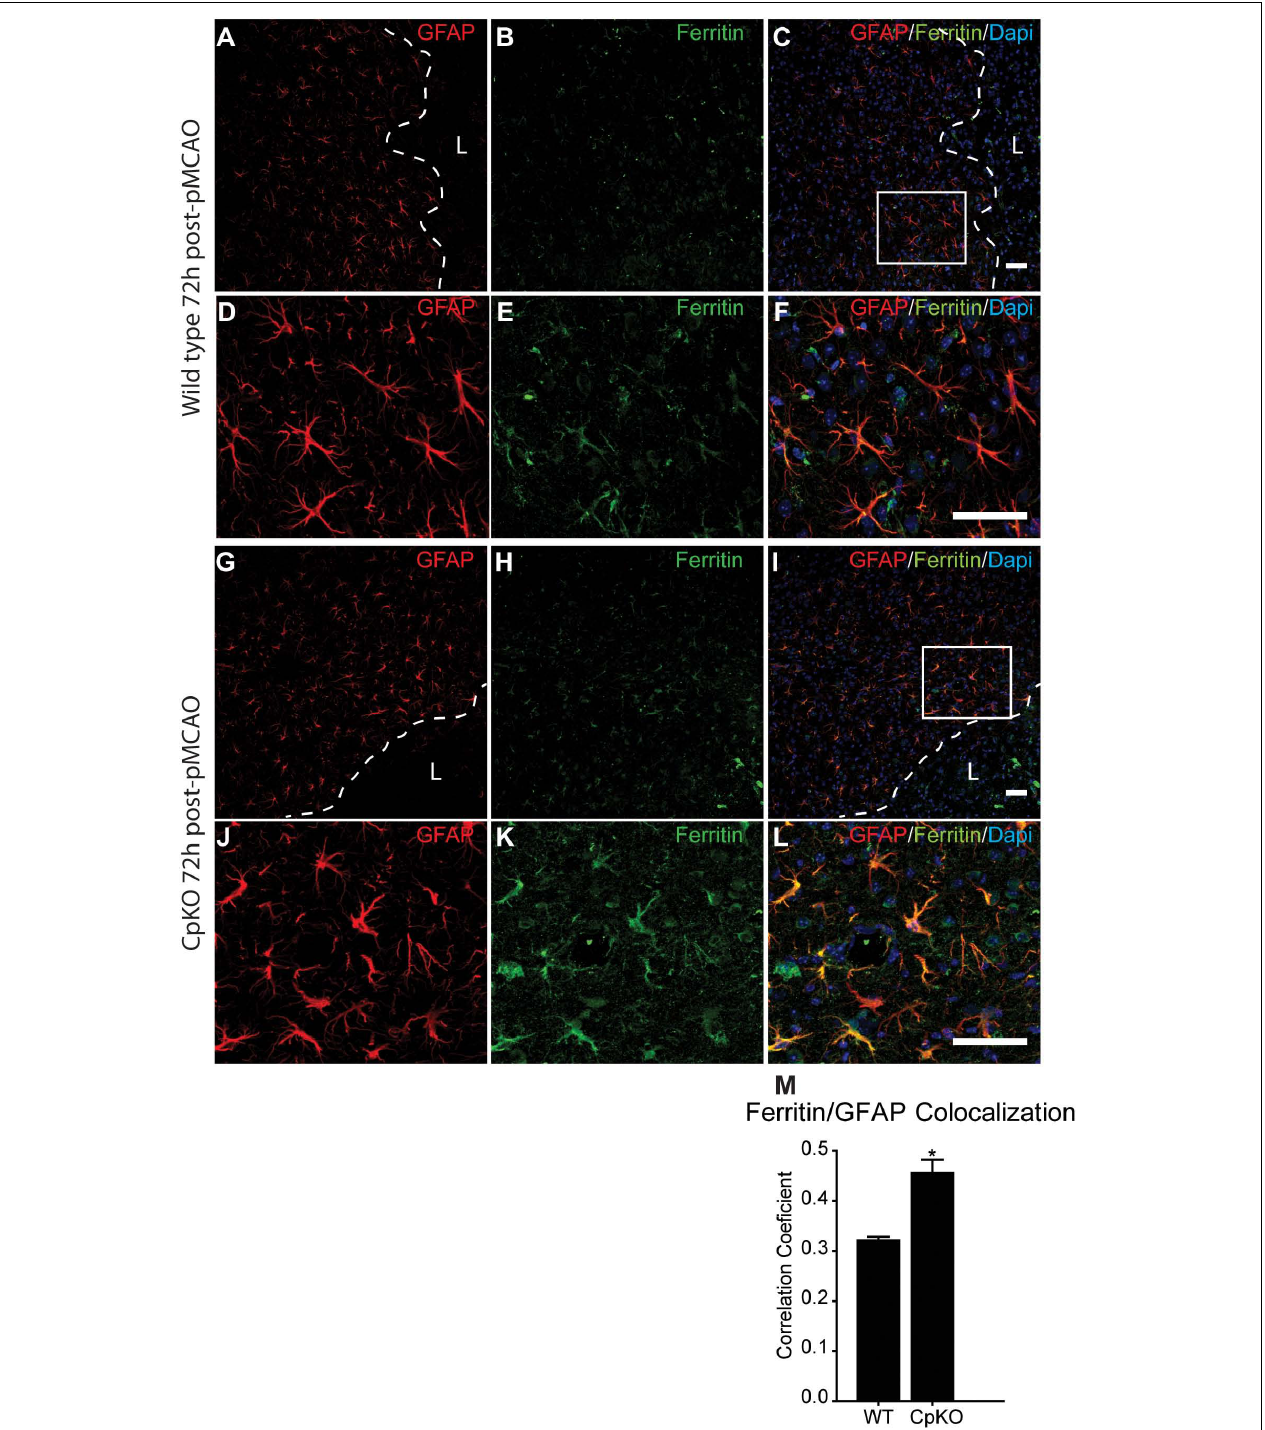
FIGURE 5 | Immunofluorescence labeling for ferritin in astrocytes. Low magnification images of the border region of the infarct and the peri-infarct region in wildtype (A–C) and Cp KO (G–I) mice 72 h after pMCAO. Dotted line demarcates the lesion boundary and L marks the lesion site. The area in the white square in panels C,I are shown at higher magnification in panels D–F and J–L . Note increase in the number and intensity of the ferritin labeling in CpKO mice (K) as compared to the wildtype mice (E) . The number of astrocytes that are double labeled for ferritin is higher in the Cp KO (K) than in wildtype mice (E) . The merged images (C,F,I,L) show GFAP, ferritin and DAPI nuclear staining. (M) Graph showing the extent of double labeling of GFAP and ferritin estimated using Pearson’s correlation coefficient ( n = 4). Scale bar = 50 µ m, ∗ p -value ≤ 0.05.